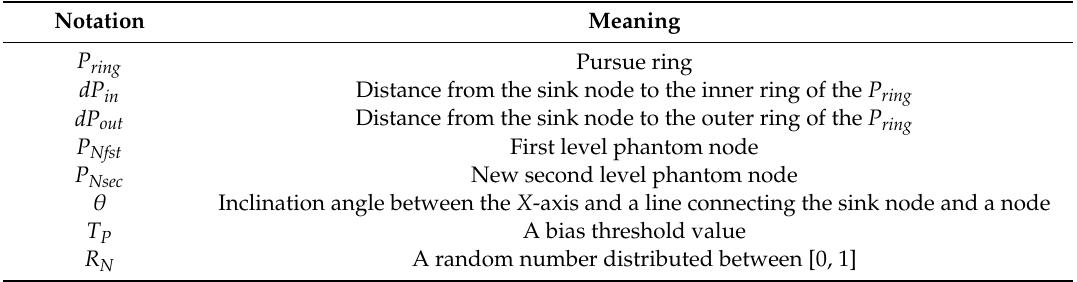
Table 3. Notations used in the proposed two-level phantom with a pursue ring (PhaP)